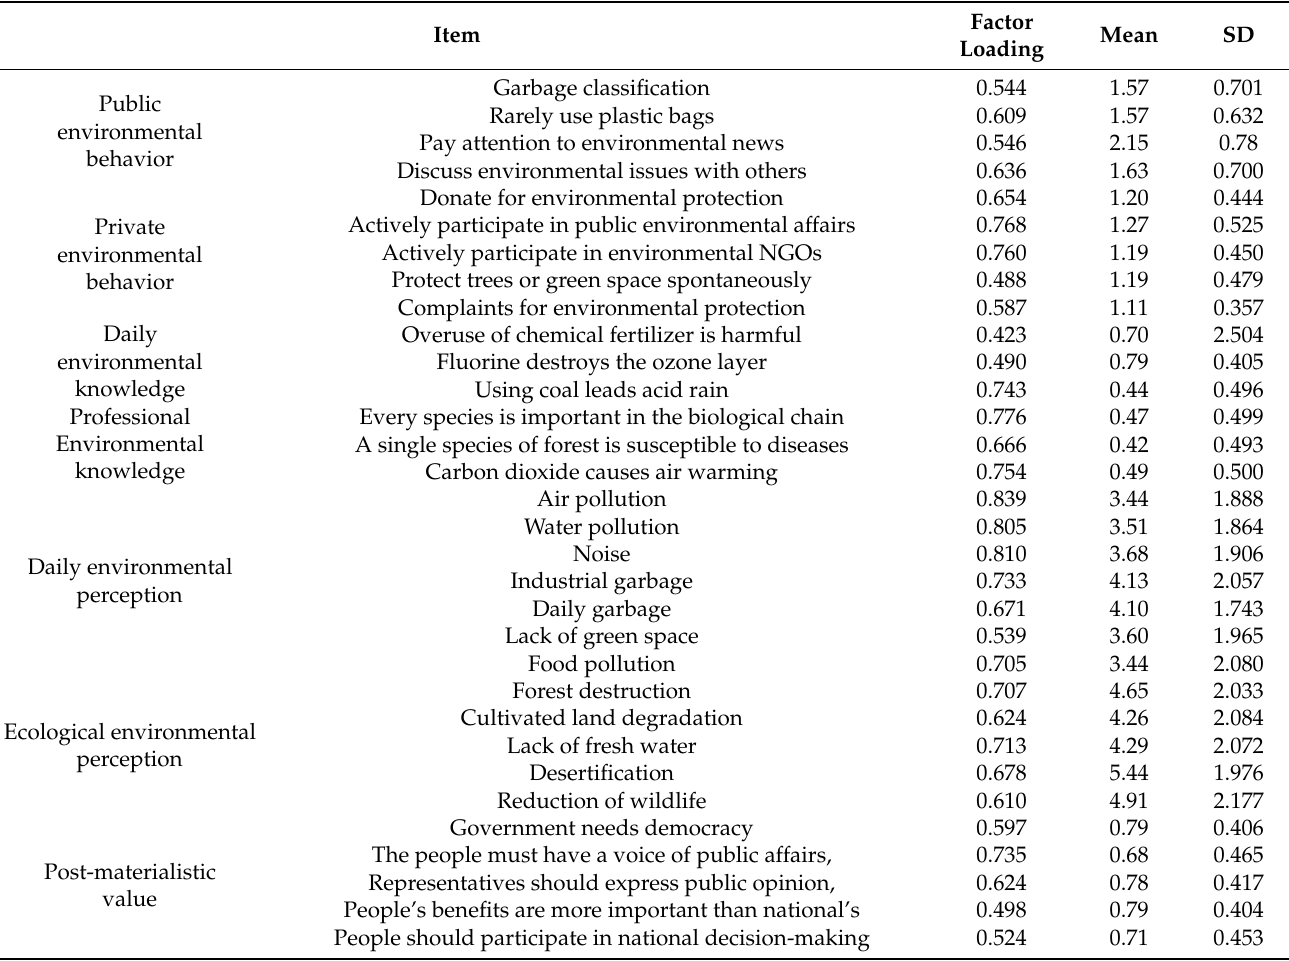
Table 1. Correlations and descriptive statistics for study